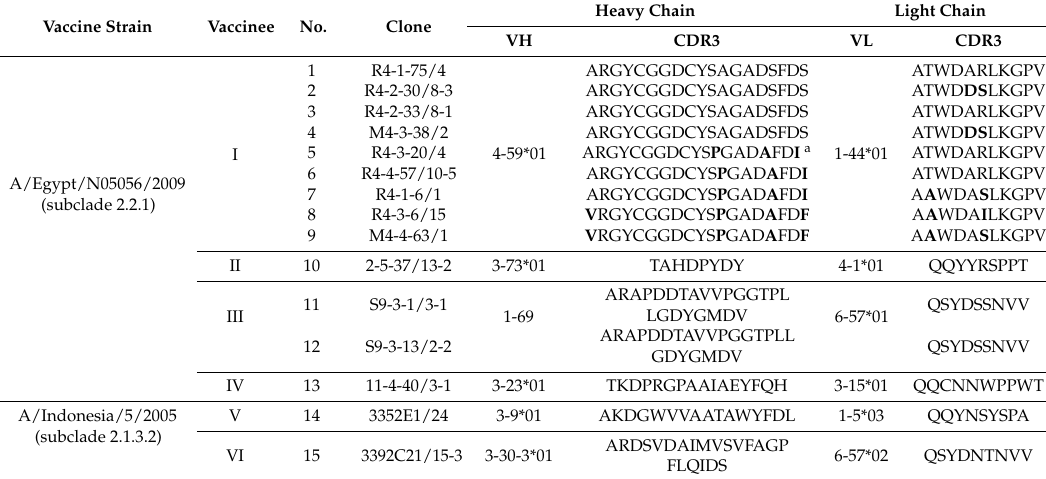
Table 2. Genetic hallmarks of the human mAbs used in this